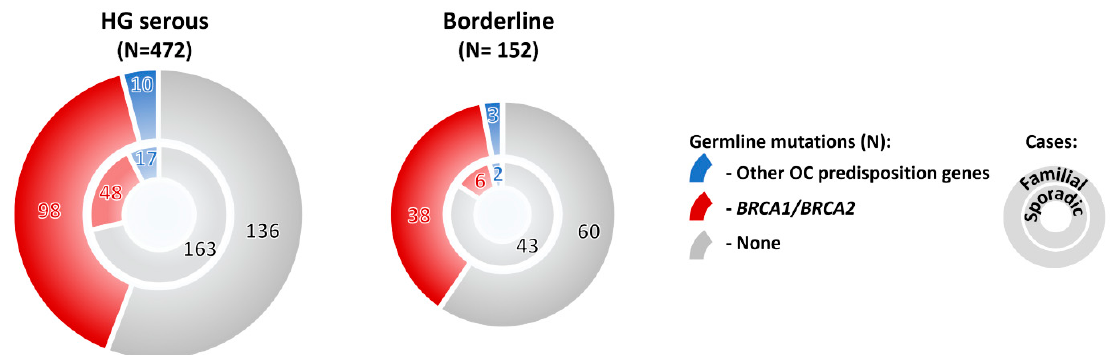
Figure 3. Frequency of mutations in 10 BC / OC predisposition genes significantly associated with OC in our study in OC patients with high-grade (HG) serous and borderline tumors, respectively. The patients were subdivided into subgroups with positive (familial cases) and negative (sporadic cases) family cancer history, respectively.